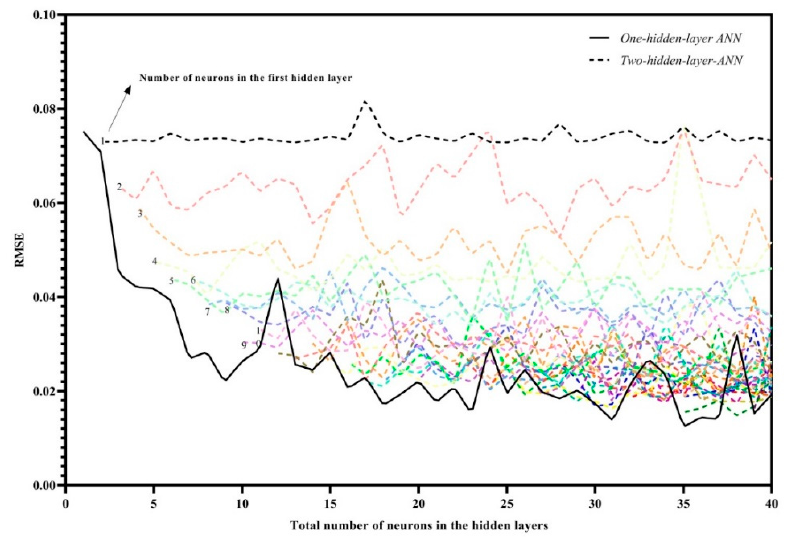
Figure 6. MLP: dependence of the RMSE at the end of training on the total number of neurons in the ANN, featuring either one or two hidden layers.